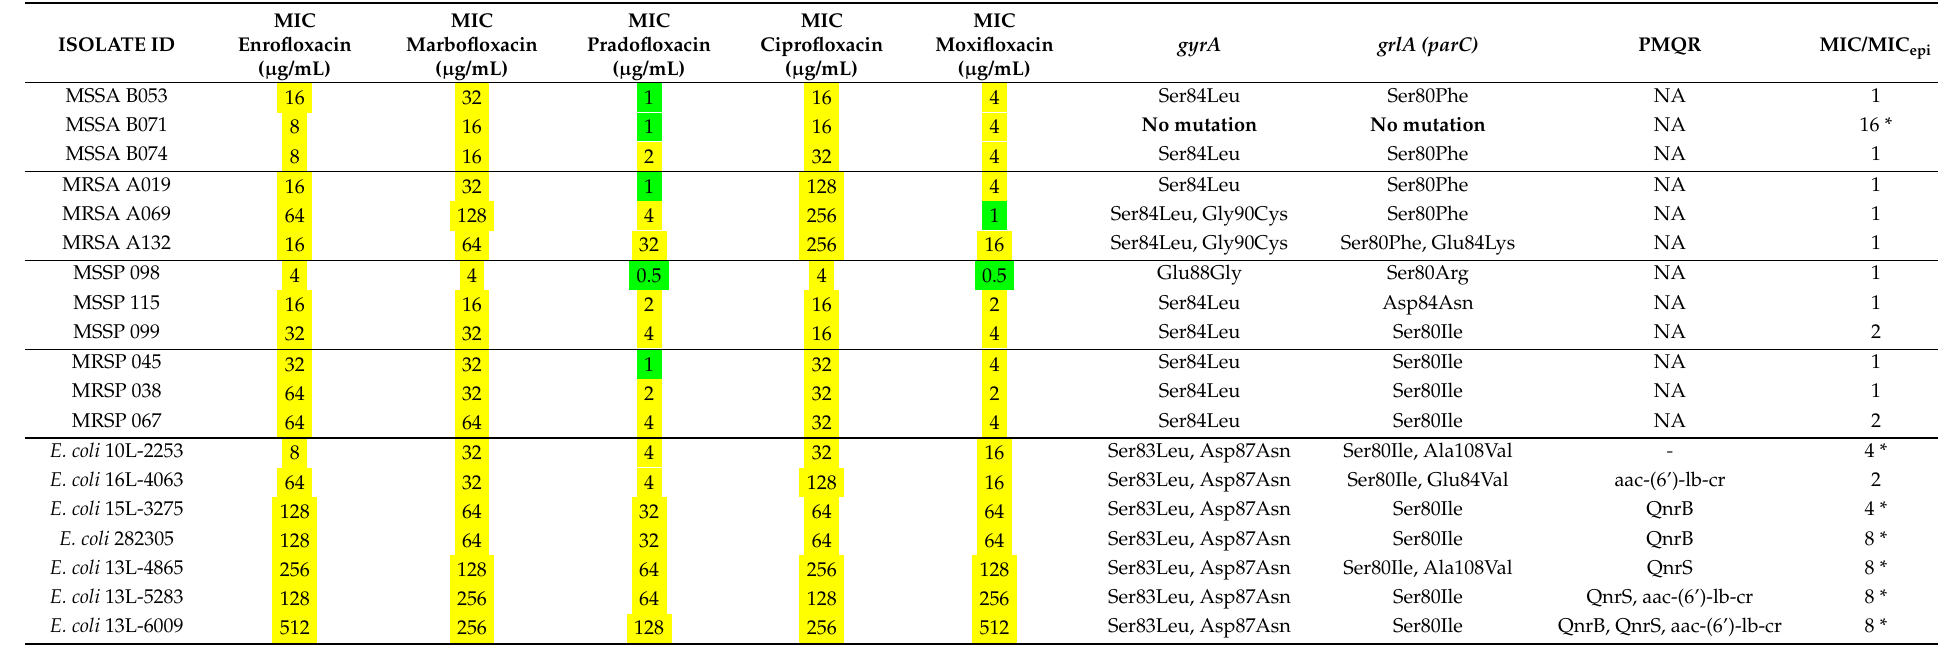
Table 2. Molecular analysis of 18 selected FQ-resistant isolates. Comparison between chromosomal mutations on DNA gyrase ( gyrA ) and topoisomerase IV ( grlA / parC ), plasmid mediated quinolone resistance (PMQR), ratio between MIC of pradofloxacin and MIC with pradofloxacin + efflux pump inhibitor (MIC epi )